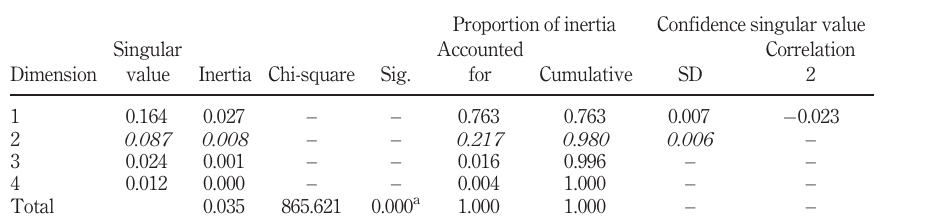
Table 2. Correspondence table